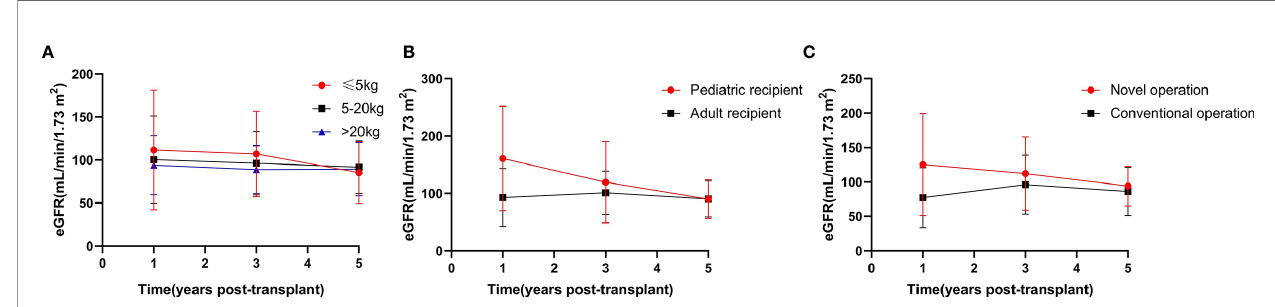
( Table 5 ). Donor age and the age and weight of recipients were signi fi cantly lower in the novel operation than in the conventional operation group. We observed no signi fi cant intergroup differences in patient survival, graft survival, death-censored graft survival rates ( Figure 6 ) and post-transplantation eGFR ( Figure 4C ). Urinary leakage rates were signi fi cantly lower in the novel operation than in the conventional operation group. The urine leakage rate in the novel operation group was 0.196-fold less than conventional operation group. The thrombosis, DGF, hydronephrosis, and the conventional operation group; however, the difference was